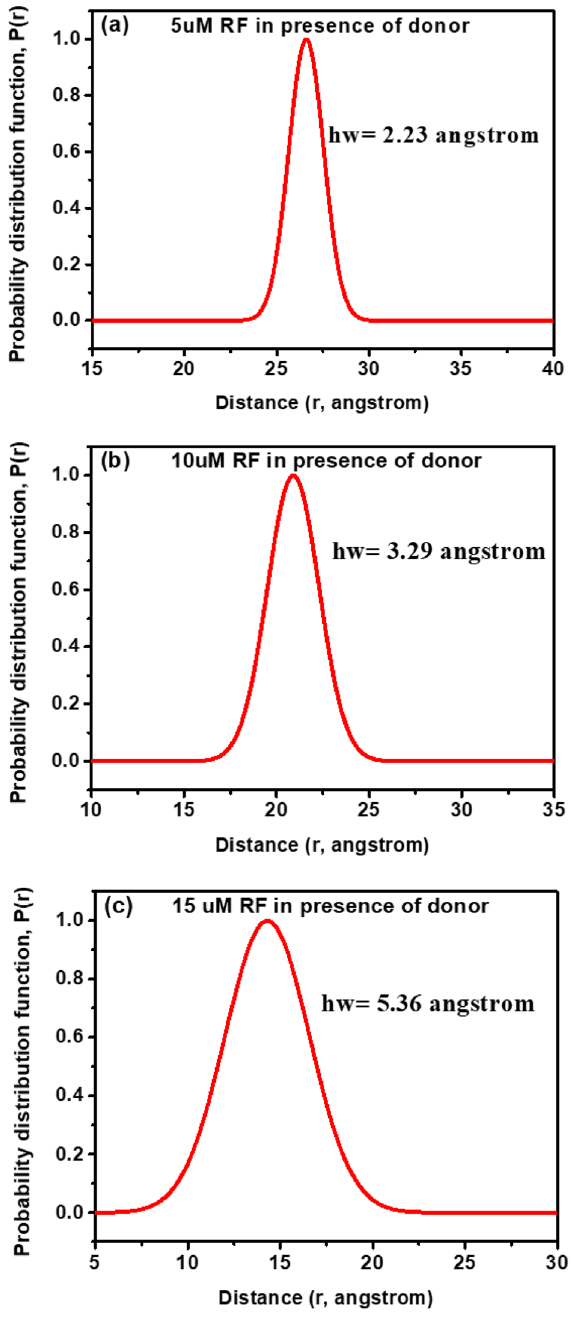
Figure 4. Probability distribution of donor − acceptor distances between Rifampicin and 2-(2-hydroxyphenyl)- benzothiazole in CTAB micelles for different concentrations of acceptor ( a ) 5 μM, ( b ) 10 μM, ( c ) 15